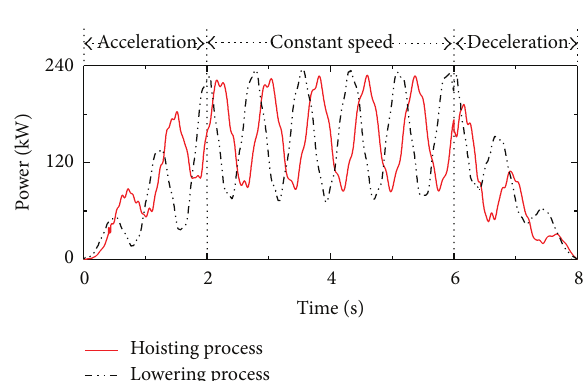
Figure 8: Time history of input power of the gear transmission.